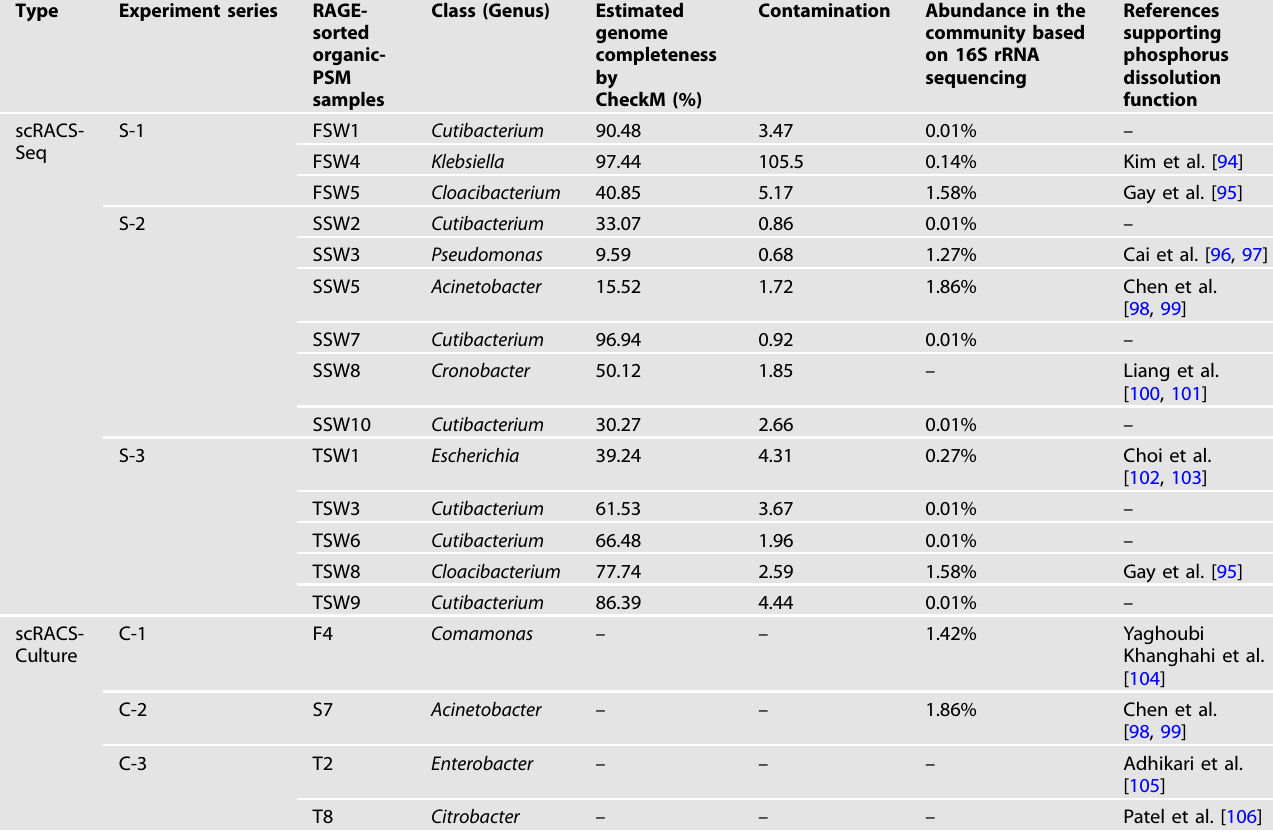
Table 1. Predicted genome completeness and species abundance of RAGE-sorted bacteria in the sewage